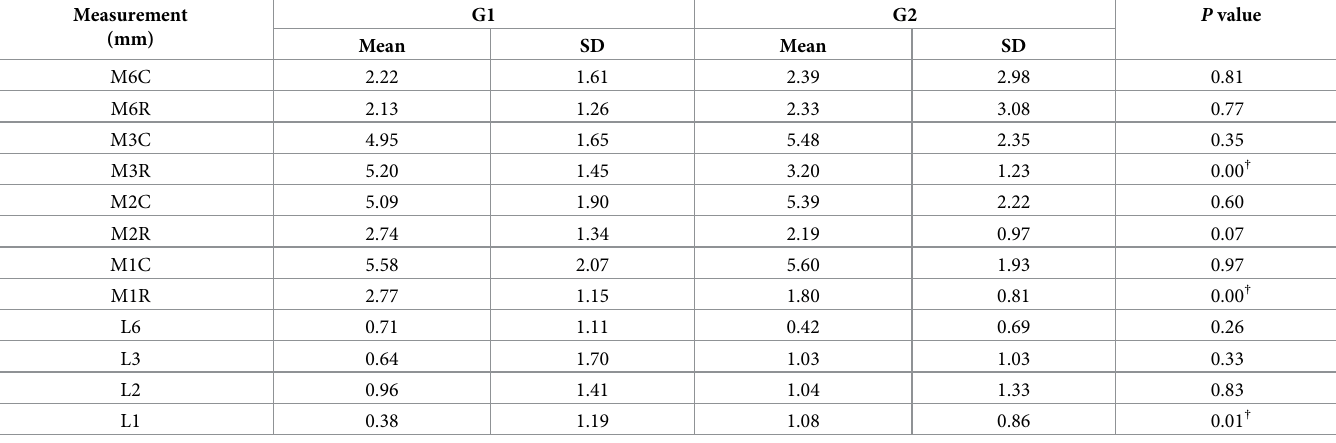
Table 3. Displacement of the landmarks and root length changes for each tooth. Measurement